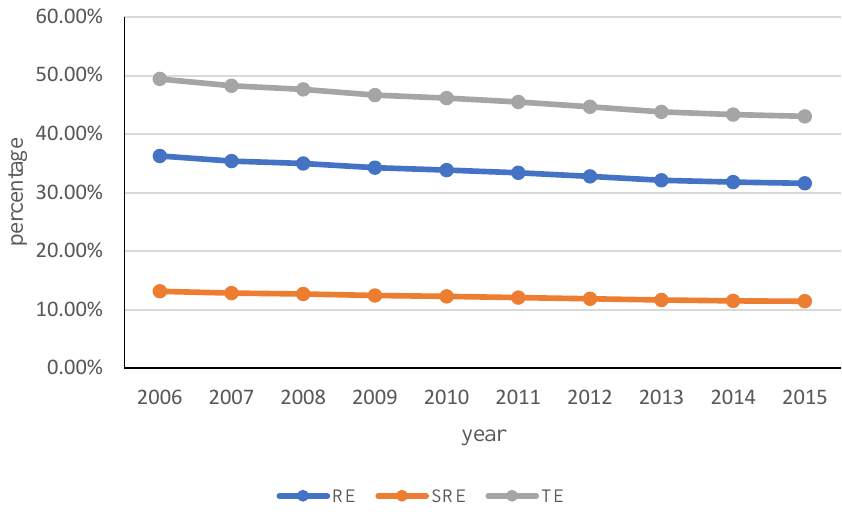
Figure 3. The changes of RE, SRE and TE from 2006 to 2015.